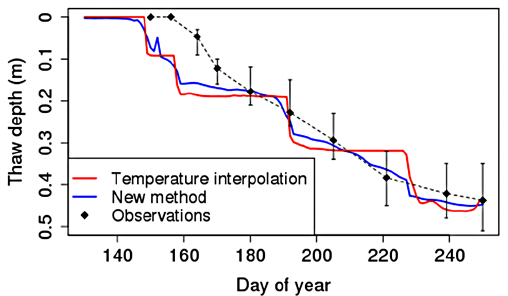
Figure 4. Thaw depth for thawing period in 2006. JULES simula- tion orgmossDS compared with observations, showing the differ- ence between two methods of calculating thaw depth. The tempera- ture method (red line) is limited by the resolution of the soil layers. Observations are means with error bars showing the full range.